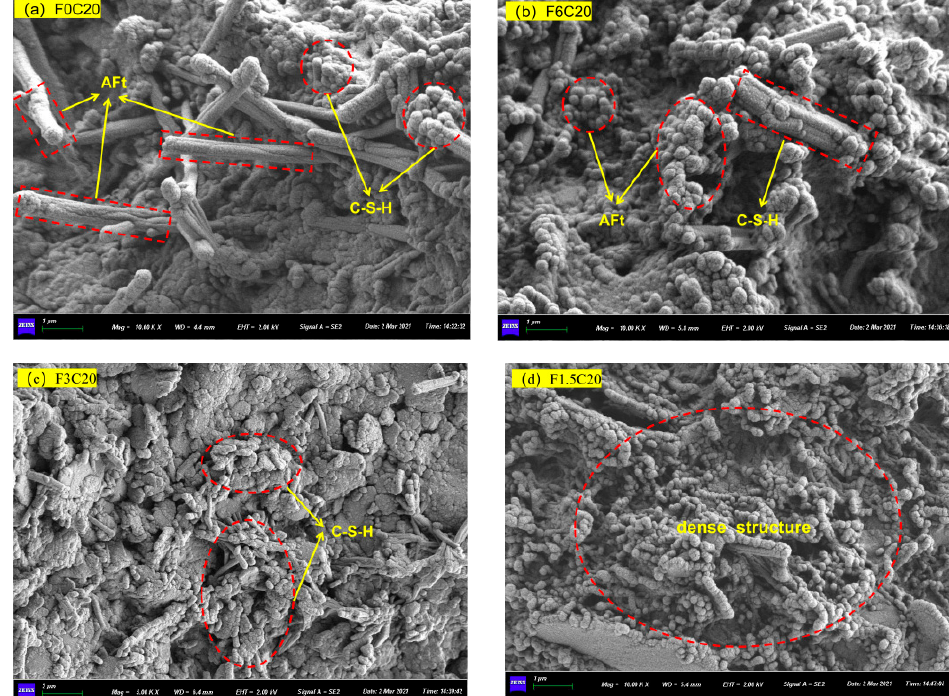
Figure 9. SEM images of CDS with different FA content cured for 28 days: ( a ) F0C20, ( b ) F6C20, ( c ) F3C20, and ( d ) F1.5C20.